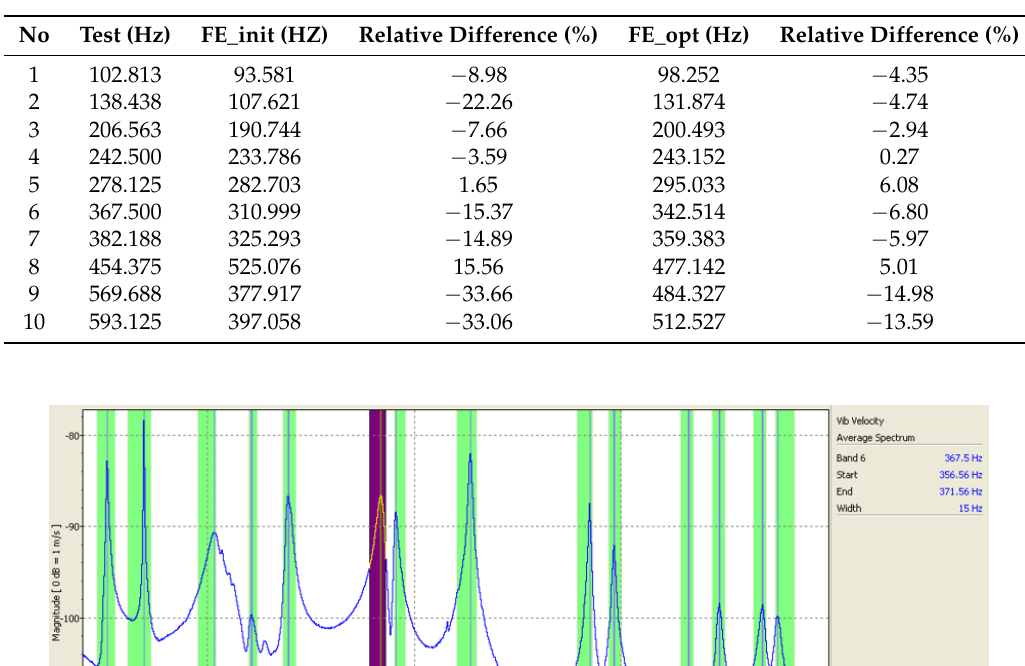
Table 2. Optimization results.